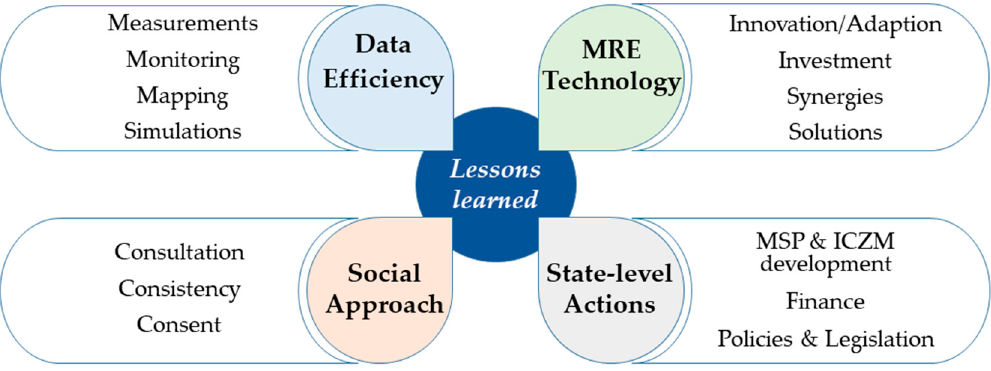
Figure 15. Schematic representation of the roadmap for MRE development in the Mediterranean Sea. MRE technology